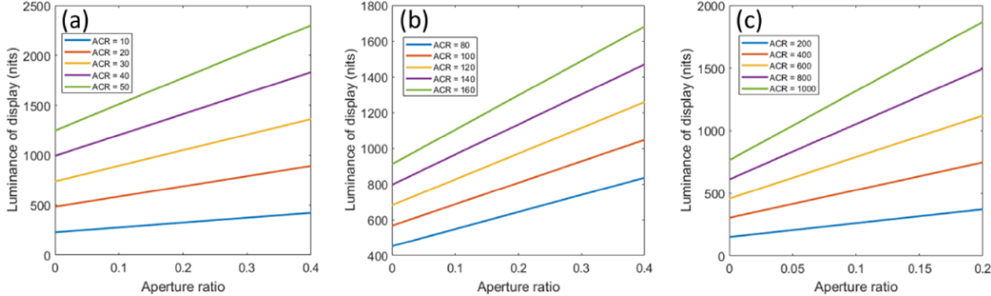
Figure 8. The luminance ambient reflectance of RGB subpixels in color-conversion micro-LED display at different aperture ratio.